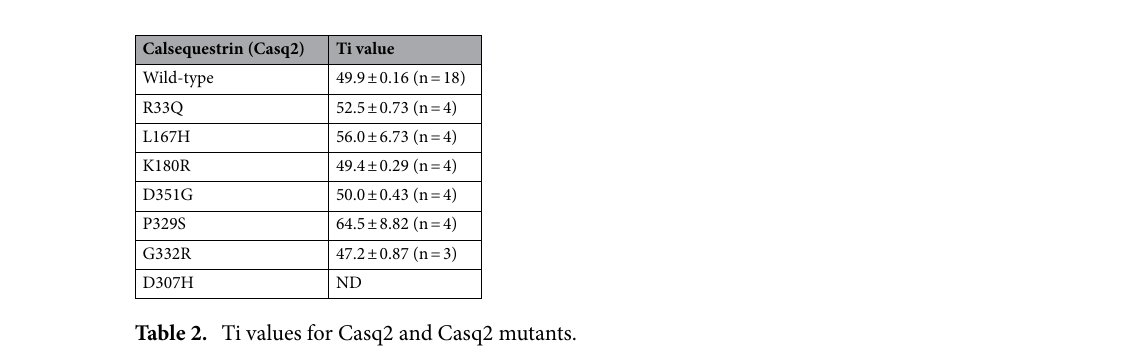
Figure 6. Thermal denaturation analysis of Casq2 and Casq2 mutants. ( A – G ) Thermal denaturation analysis of wild-type Casq2 (black lines) or Casq2 mutants (red lines) was monitored by intrinsic tryptophan fluorescence of proteins in response to increased temperature from 35 to 95 °C. Graphs represent 3 independent measurements. ( H ) Inflection temperature for Casq2 and Casq2 mutants representing the temperature at which the transition from folded protein to unfolded state occurs. ( I ) Human Casq2 crystal structure (2VAF). Mutants with significant difference in their protein folding are indicated by red circles. The location of tryptophan residues are depicted as yellow sticks.